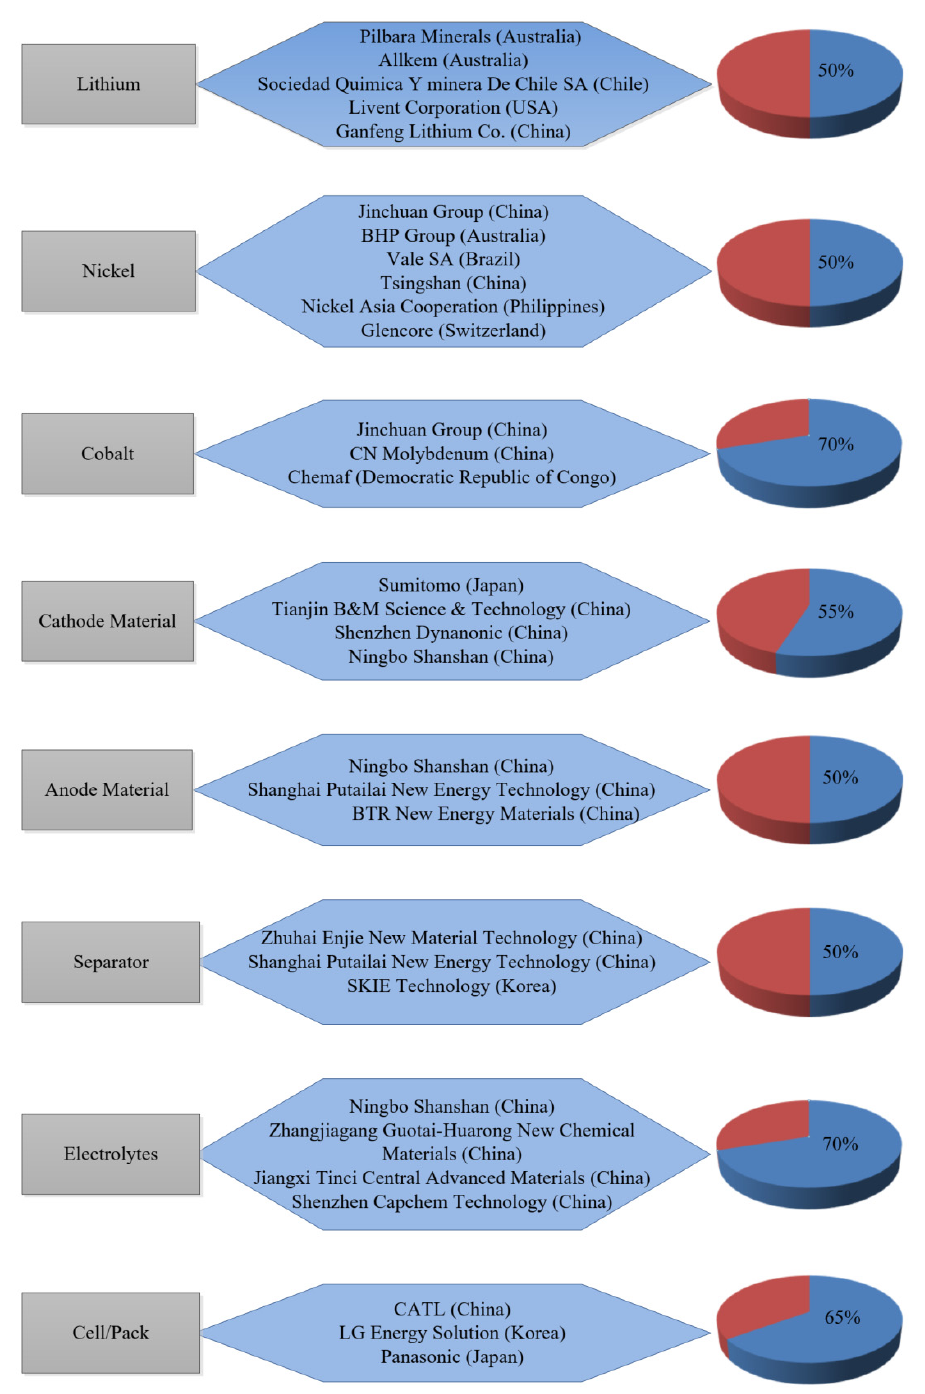
Figure 13. Industries associated in the various steps of the EV battery supply chain with their respective market